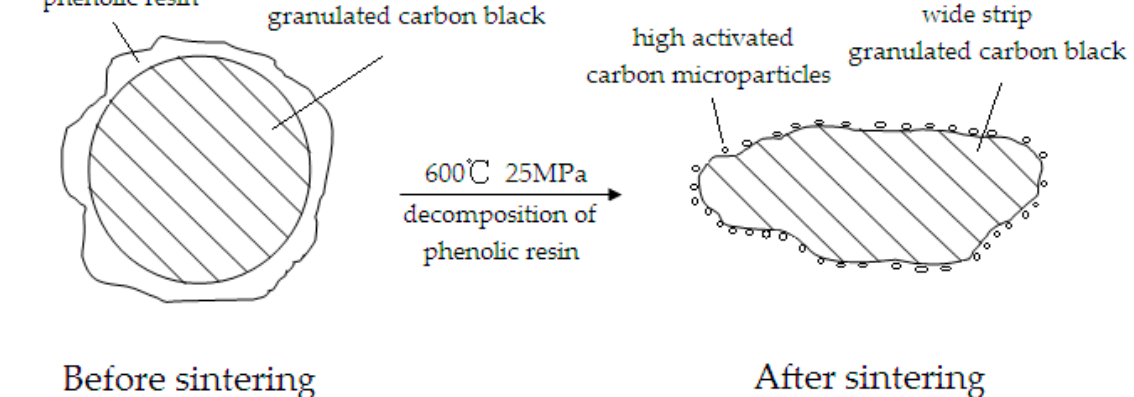
Figure 2. Schematic diagram of the lubricating phase structure change process.